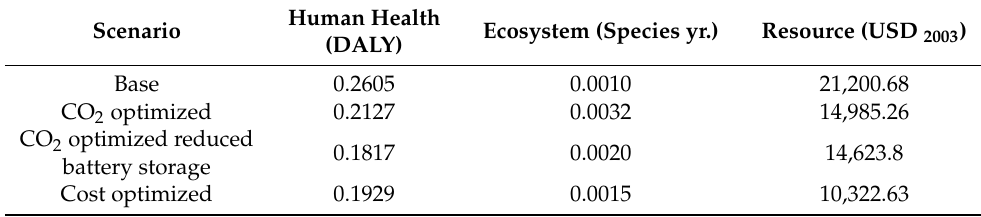
Table 3. ReCiPe endpoint results in each